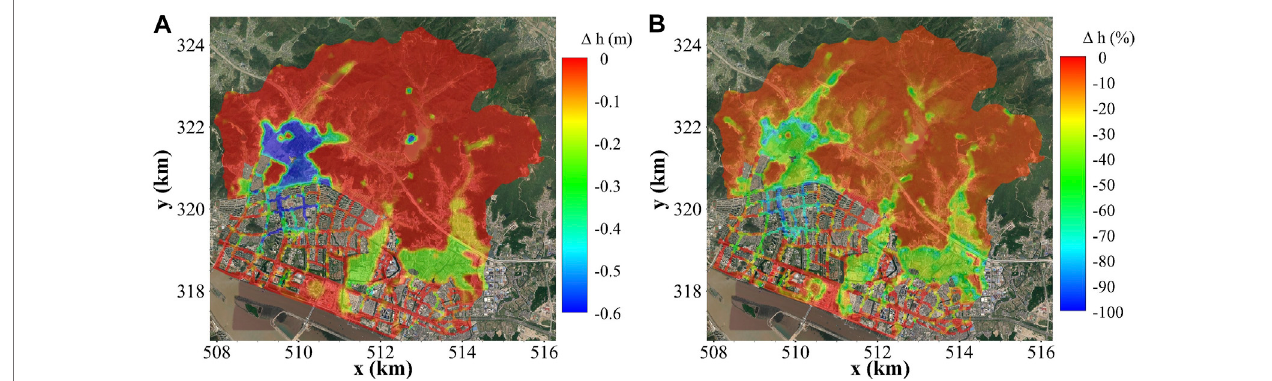
Frontiers in Earth Science |